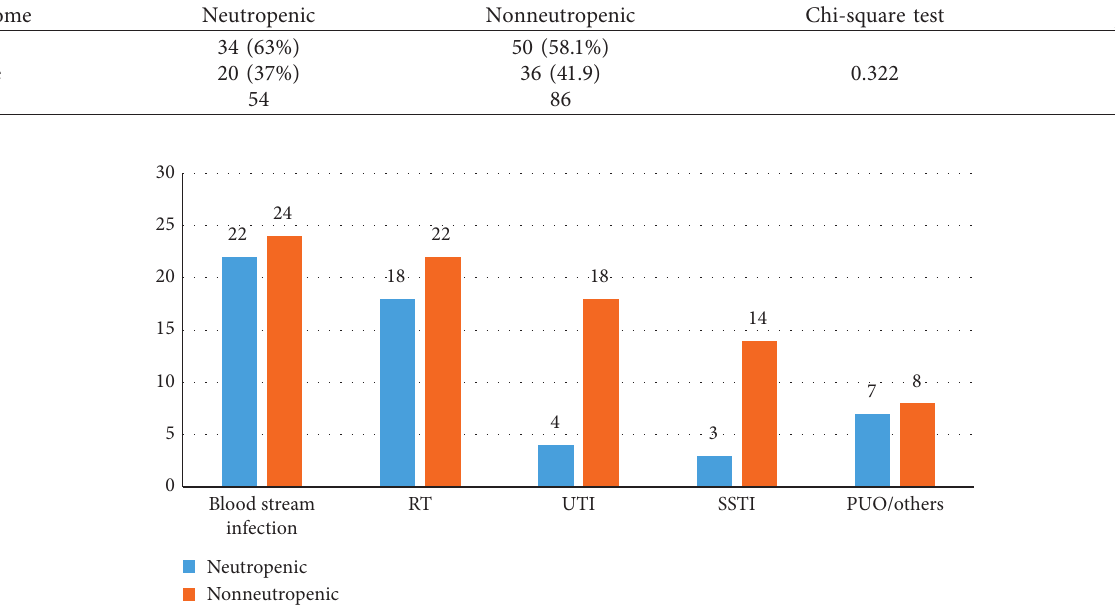
Figure 4: Distribution of infection sites in neutropenic and nonneutropenic